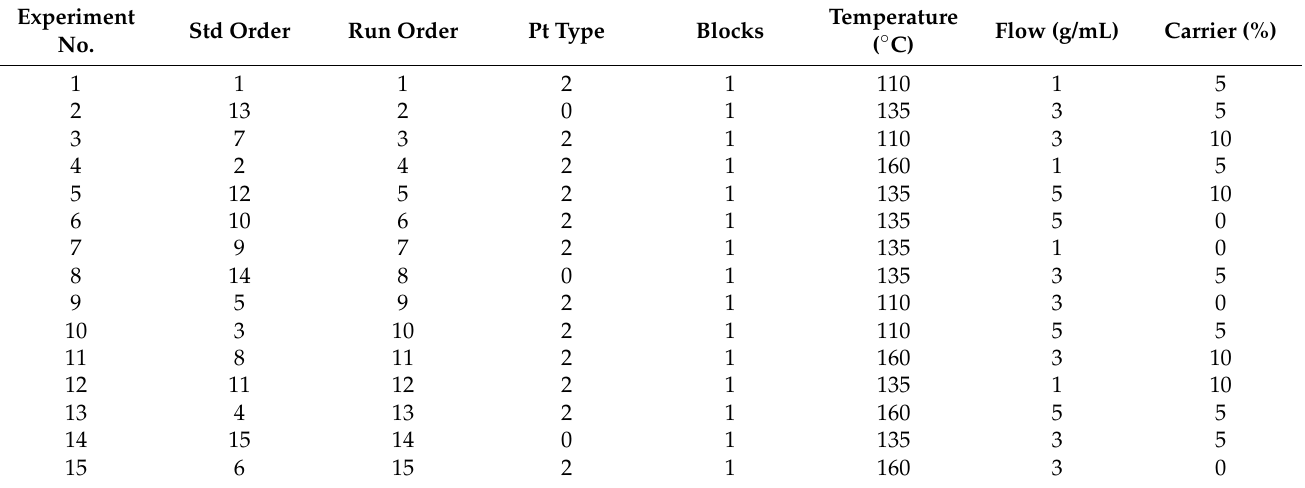
Table 1. The tamarillo spray-drying experimental design used in this study summarising the different treatments according to the Box–Behnken